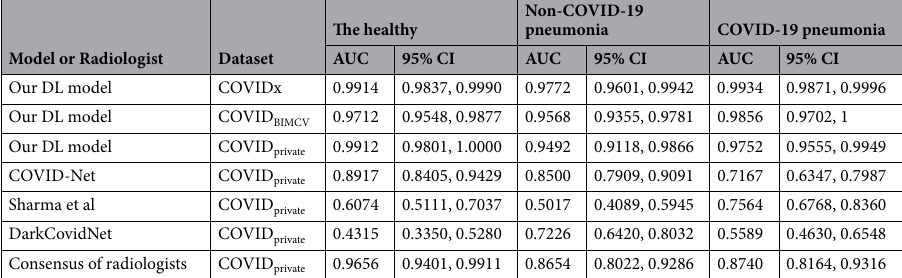
Table 4. Class-wise AUC and its 95% CI of our DL model and consensus of six radiologists. DL deep learning; CI confidence interval; AUC area under the curve; COVIDx public dataset used for COVID-Net; COVID BIMCV public dataset obtained from the PadChest dataset and the BIMCV-COVID19 + dataset; COVID private private dataset collected from six hospitals.